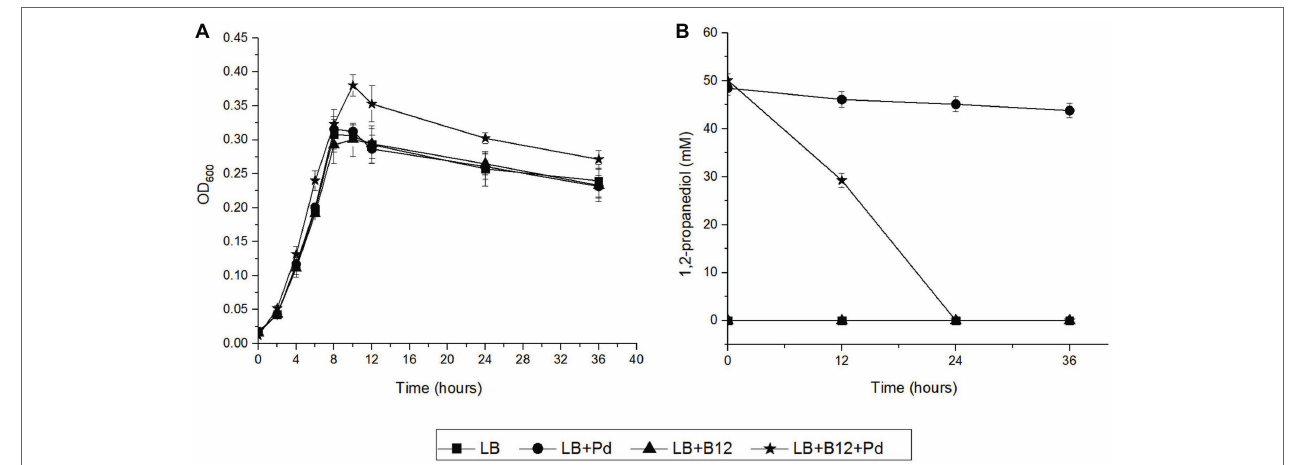
FIGURE 2 | Anaerobic growth and utilization of Pd in L. monocytogenes EGDe. (A) Impact of Pd and/or vitamin B12 on anaerobic growth of L. monocytogenes EGDe in LB medium. Symbols represent different growth conditions; Luria broth without (LB) and with added Pd (LB + Pd), with added vitamin B12 (LB + B12), and with both compounds added (LB + Pd + B12). ANOVA with post-hoc Tukey test, LB + Pd + B12 versus LB, LB + Pd, or LB + B12, p < 0.001 in 10, 24, and 36 h. Results from three independent experiments with three technical repeats expressed as mean ± s.e.m. (B) Utilization of Pd by L. monocytogenes EGDe. Symbols used are the same as in Figure 2A . Error bars in (A,B) indicate three independent experiments with three technical repeats expressed as mean ±